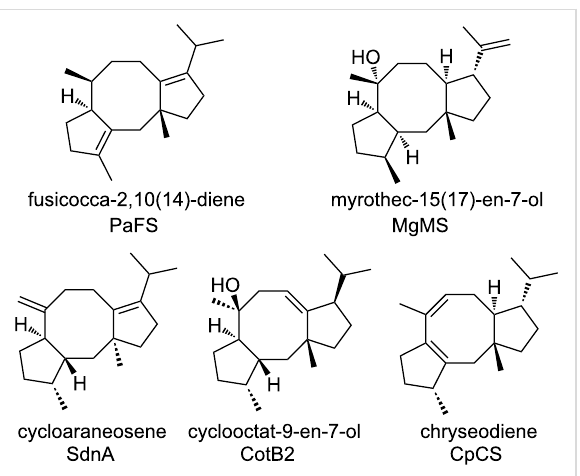
Figure 1: The five distinct FC-type DTSs and the corresponding prod- ucts.